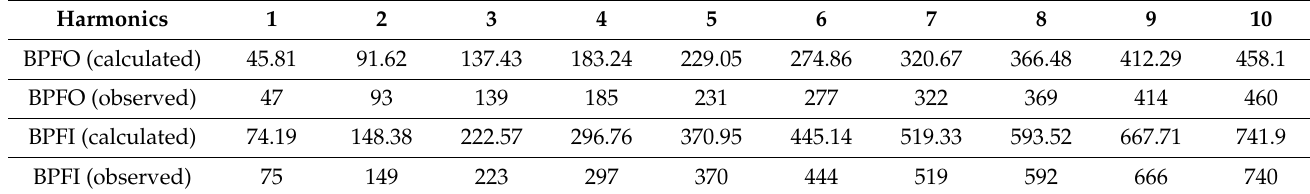
Table 5. Calculated bearing fault characteristic frequency harmonics for State 1.